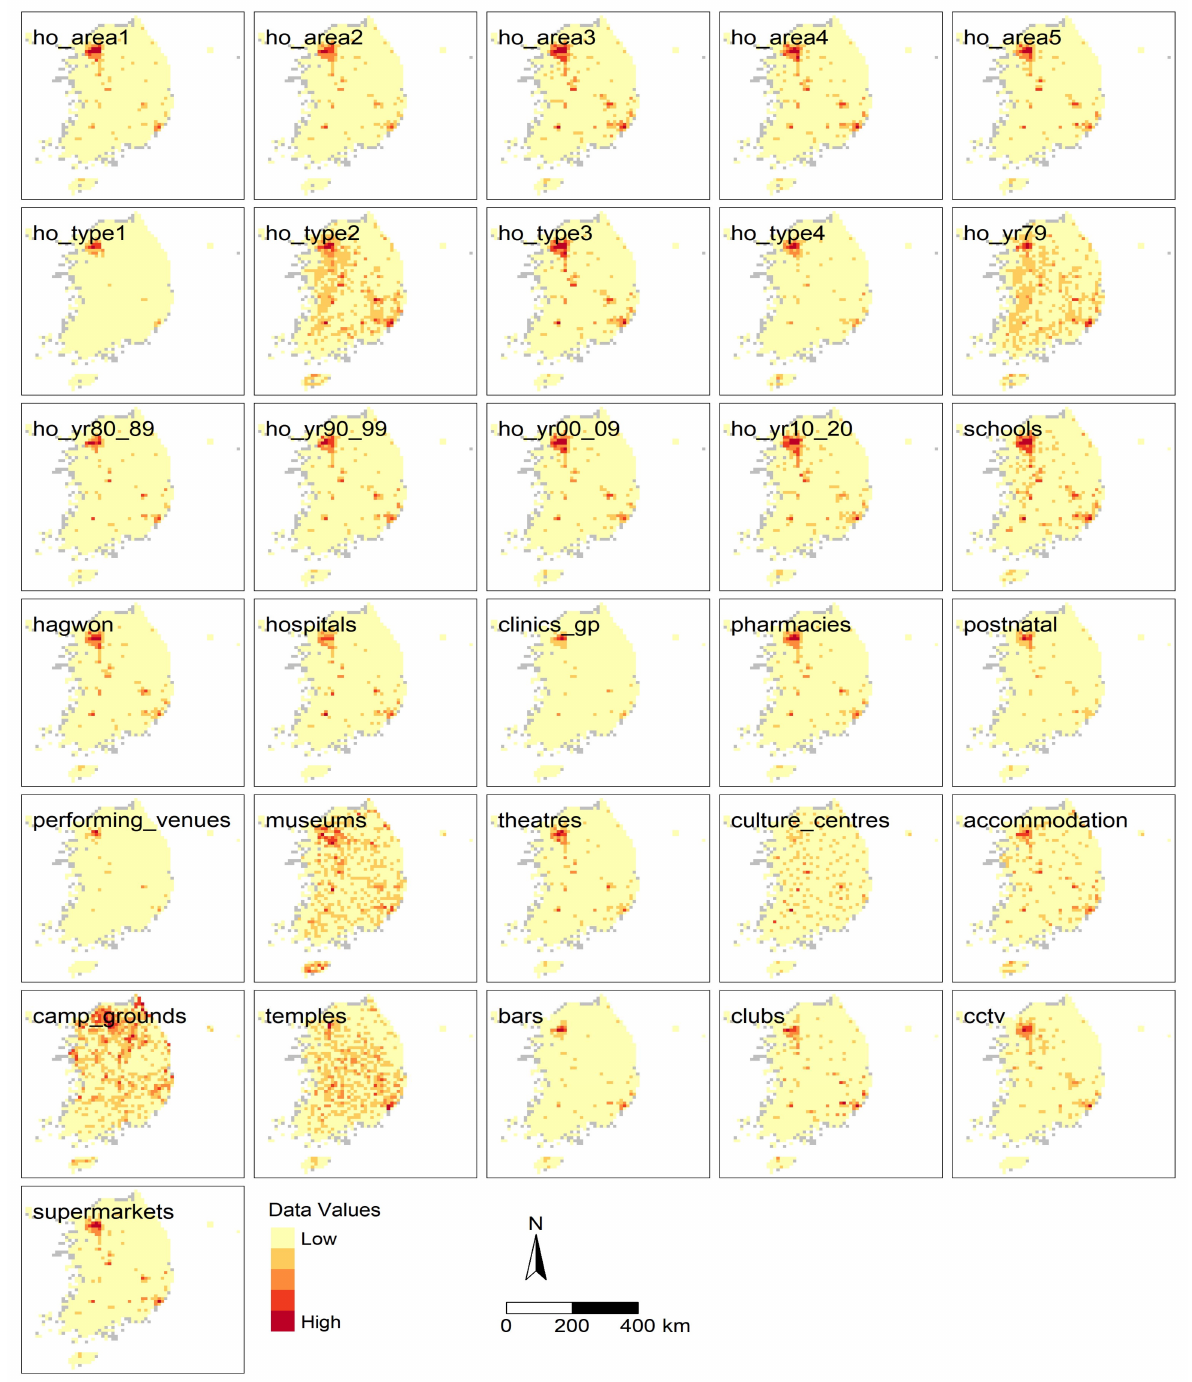
Figure 2. Spatial distribution of the social infrastructure